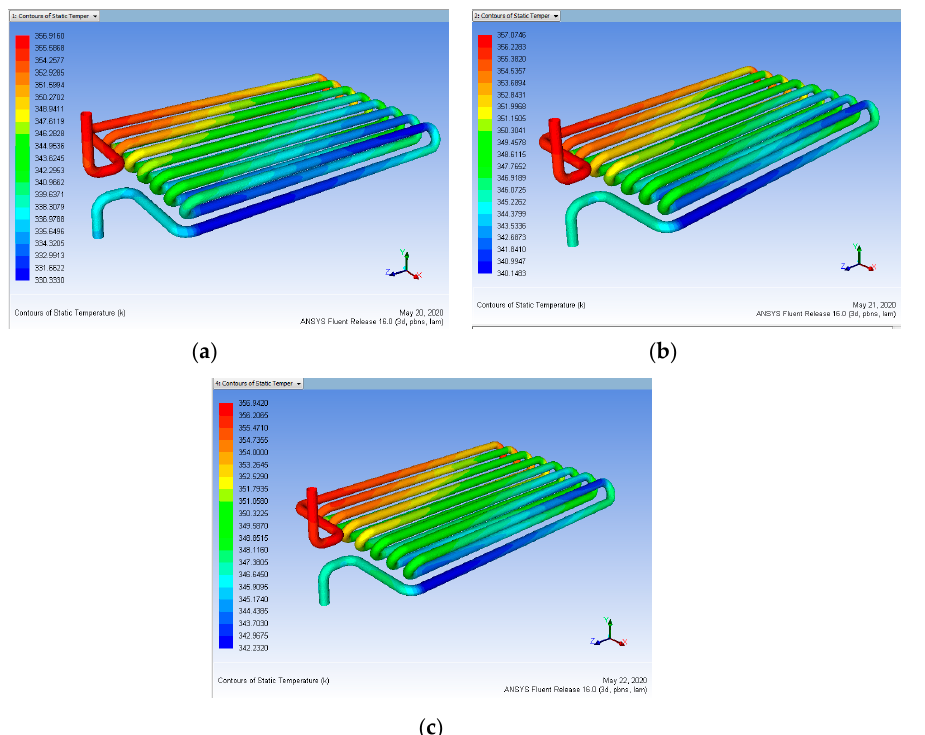
Figure 23. Heat input 363 K vs. Coating Thickness 80 µm for mass flow rate ( a ) 0.15, ( b ) 0.30, ( c ) 0.45 L/min (After Coating).